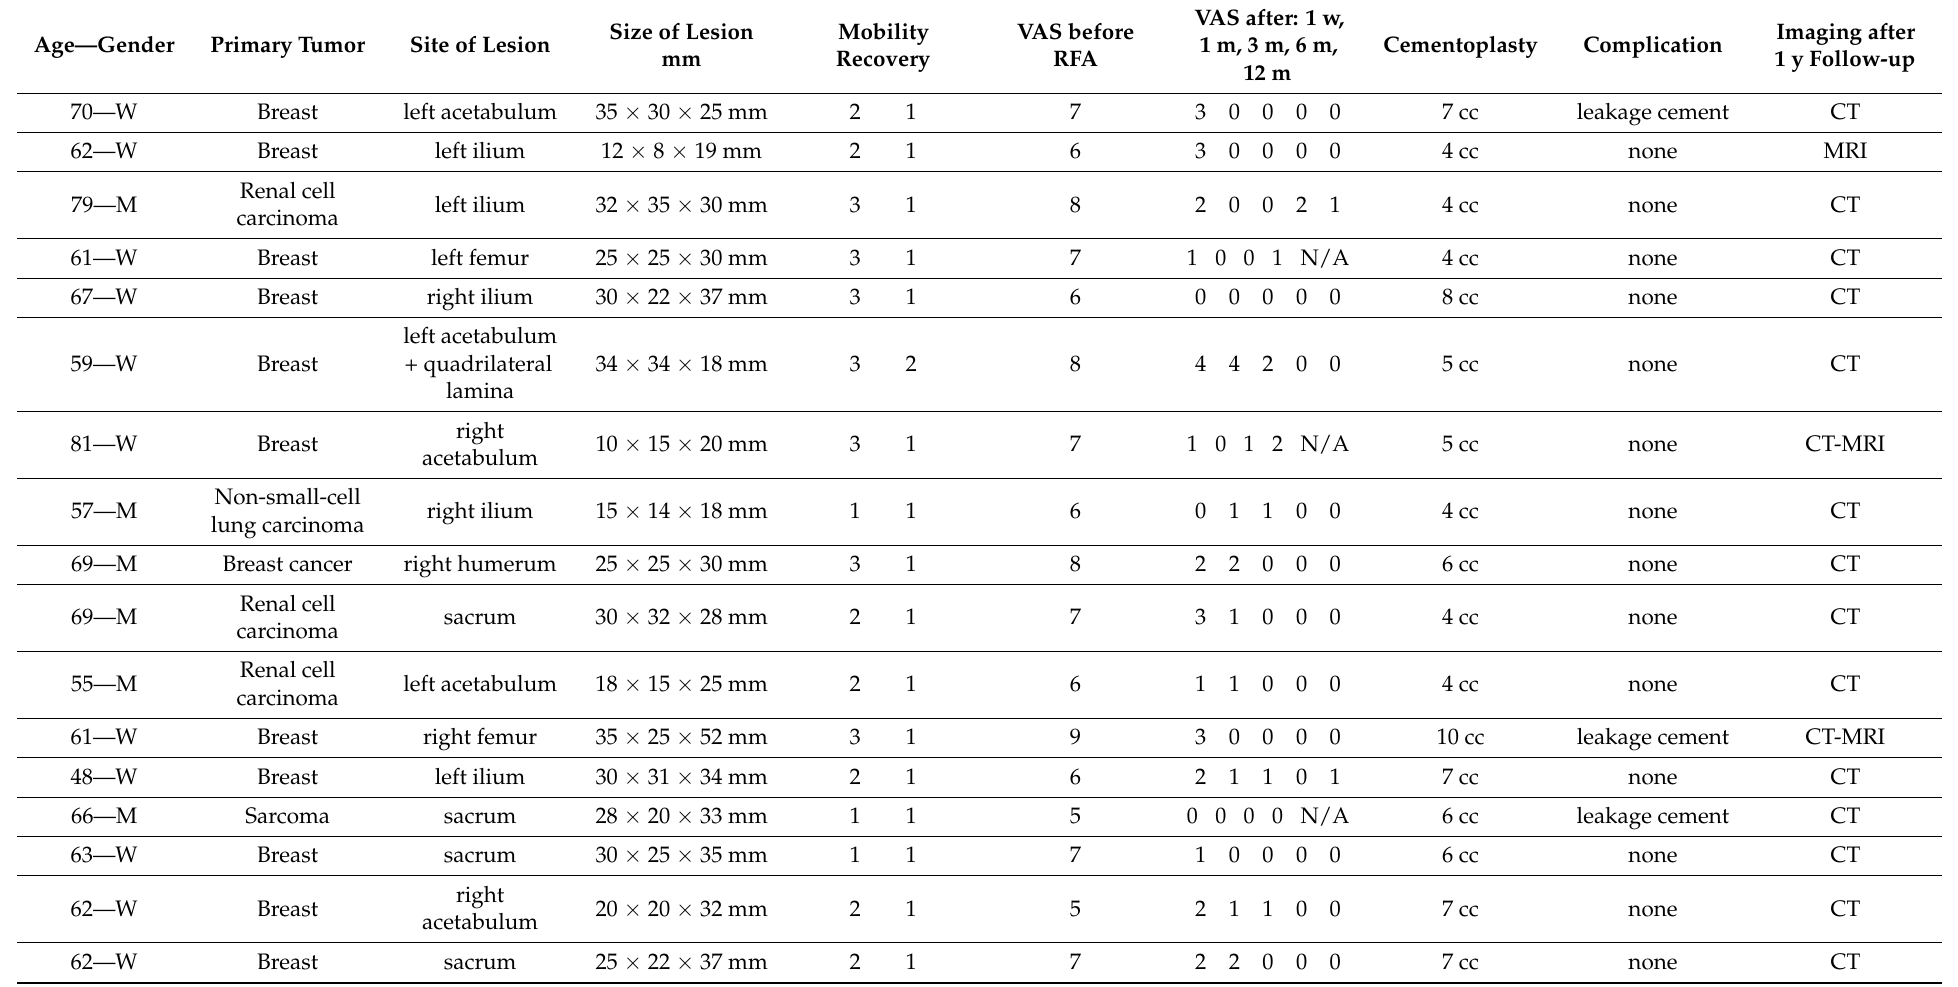
Table 1. Patients and tumor